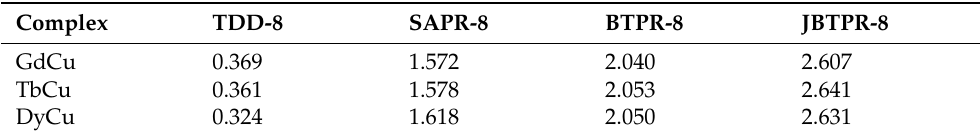
Table 1. SHAPE analyses for 2 – 4 .